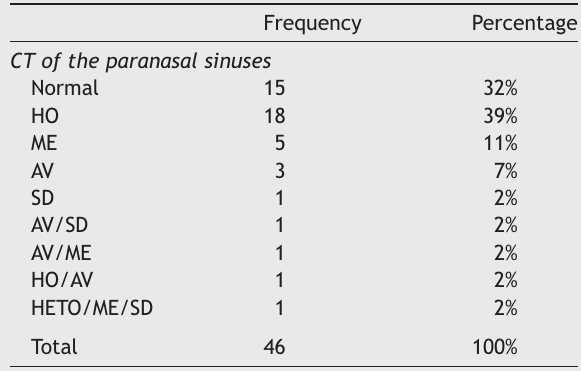
Frequency between rhinosinusitis (RS) recurrence and graft vs. host disease (GVHD).